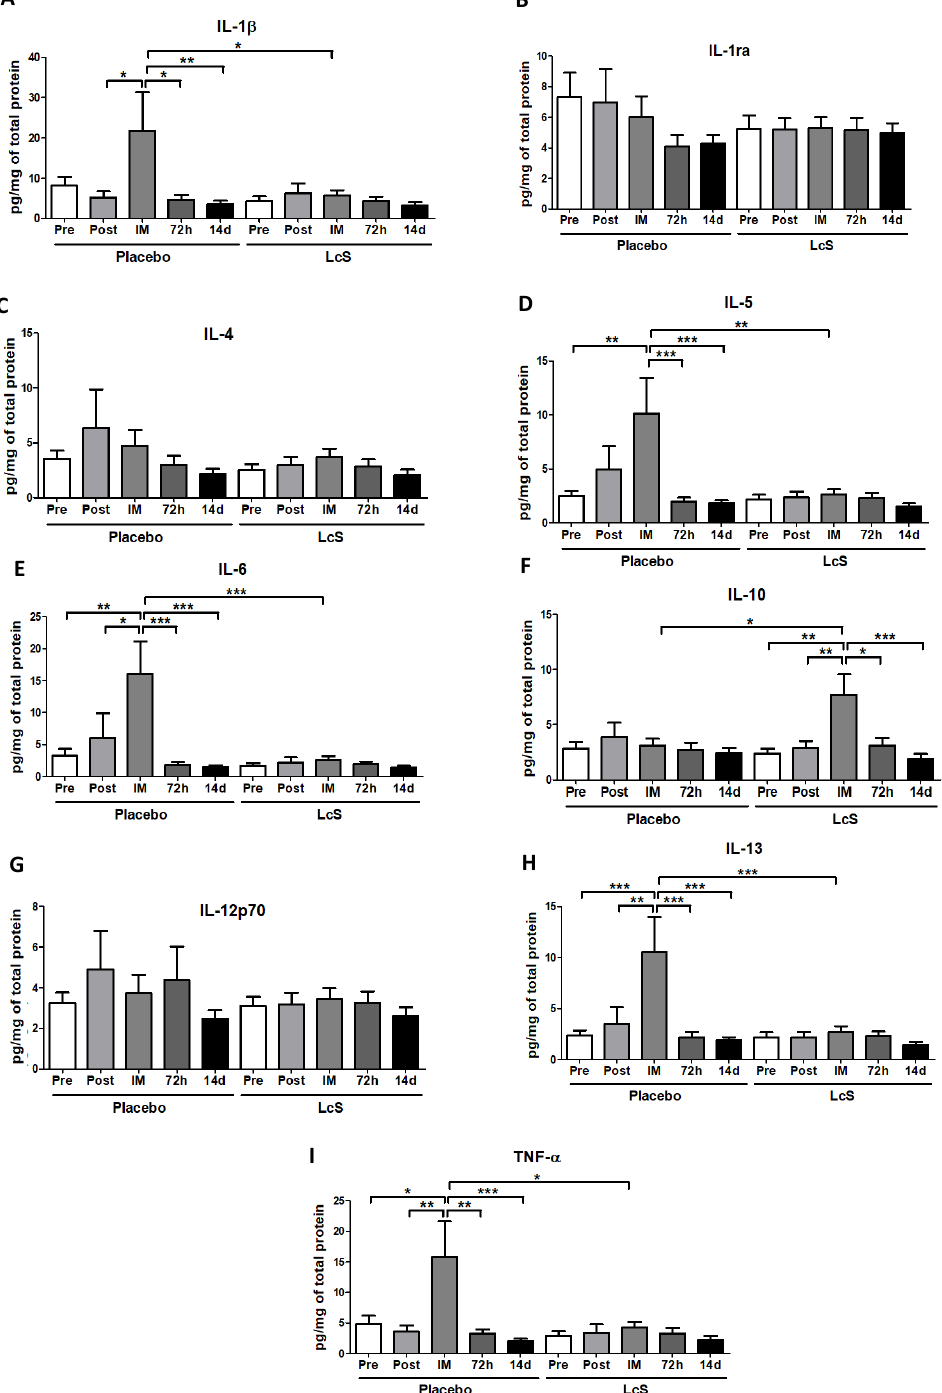
Figure 4. LcS increase anti-inflammatory response on the upper airways after the marathon. Concentration (pg / mg of total protein) of IL-1 β ( A ) , IL-1ra ( B ) , IL-4 ( C ) , IL-5 ( D ) , IL-6 ( E ) , IL-10 ( F ), IL-12p70 ( G ) , IL-13 ( H ), and TNF- ( I ) in nasal mucosal lavage of the volunteers in the placebo and LcS groups at five di ff erent occasions: before (Pre) and 30 days after the ingestion of the fermented milk containing or not containing LcS (Post-ingestion); immediately (IM); 72 hours (72 h) and 14 days (14 d) after the marathon ends. Values are presented in median with the respective quartiles. * p < 0.05; ** p < 0.01 and *** p <